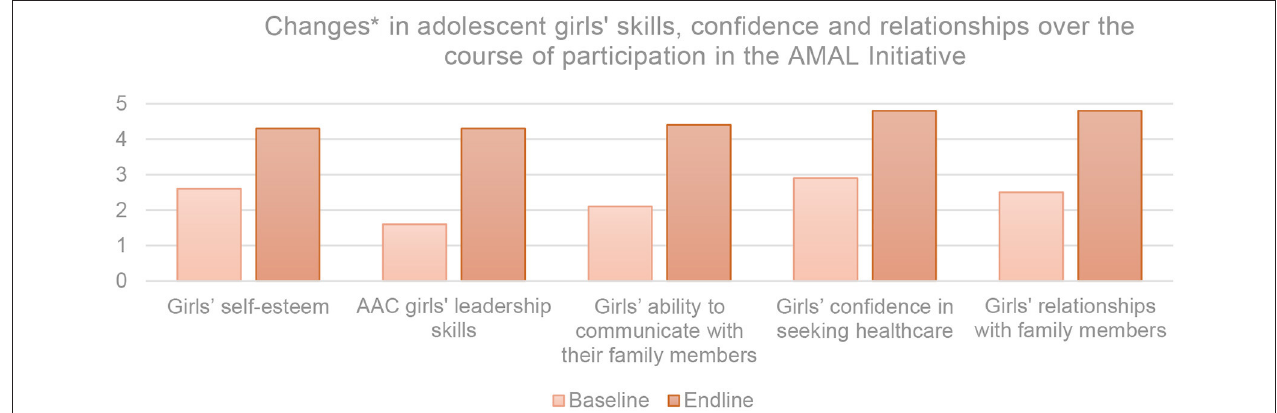
FIGURE 2 | Consolidated changes between baseline and end line in AMAL adolescent participants’ self-report of skills, confidence, and relationships on a five-point Likert Scale. *Measured through a consolidated analysis of norms statements using five-point Likert Scale wherein 1, strongly disagree; 2, disagree; 3, neutral; 4, agree; and 5, strongly